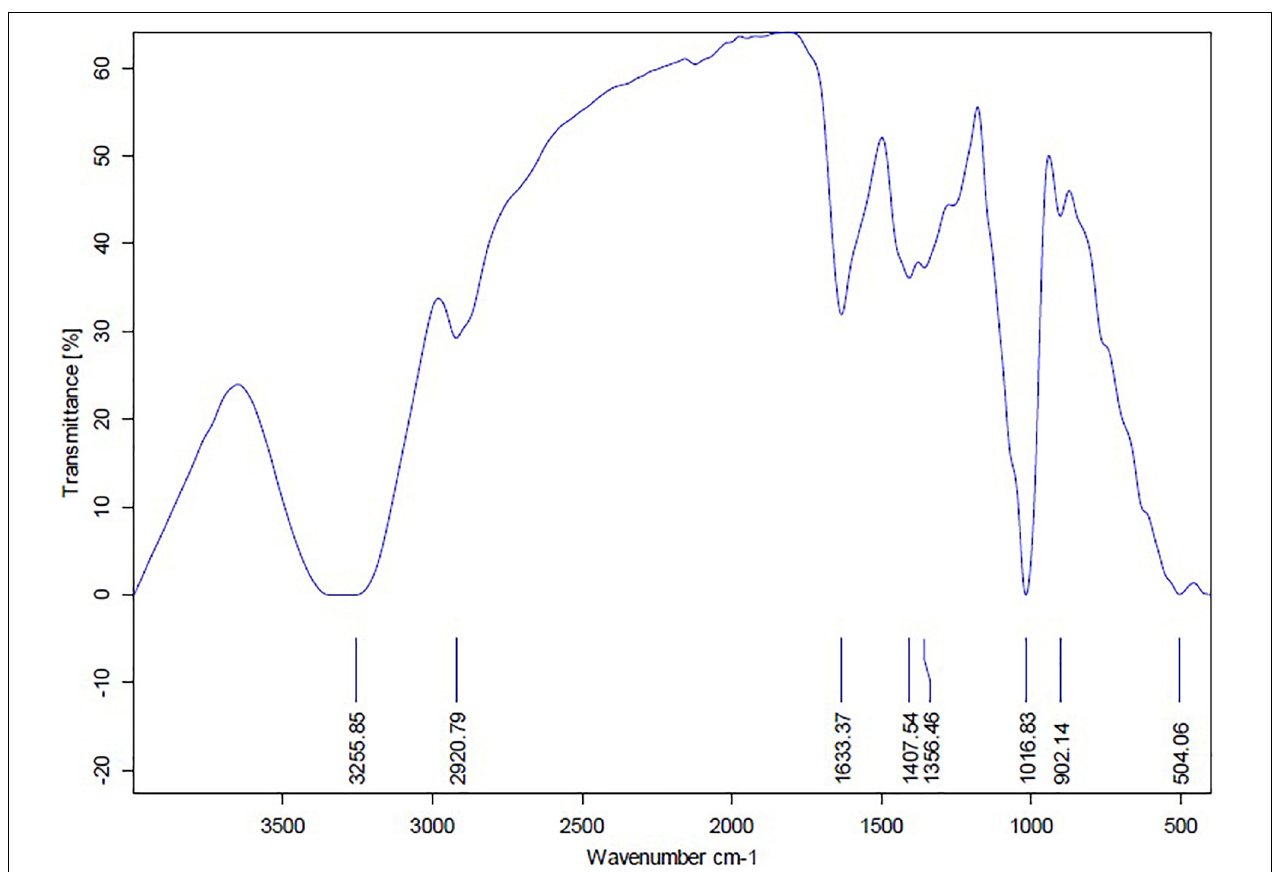
FIGURE 10 | FTIR spectrum of mycelial extract of A. terreus